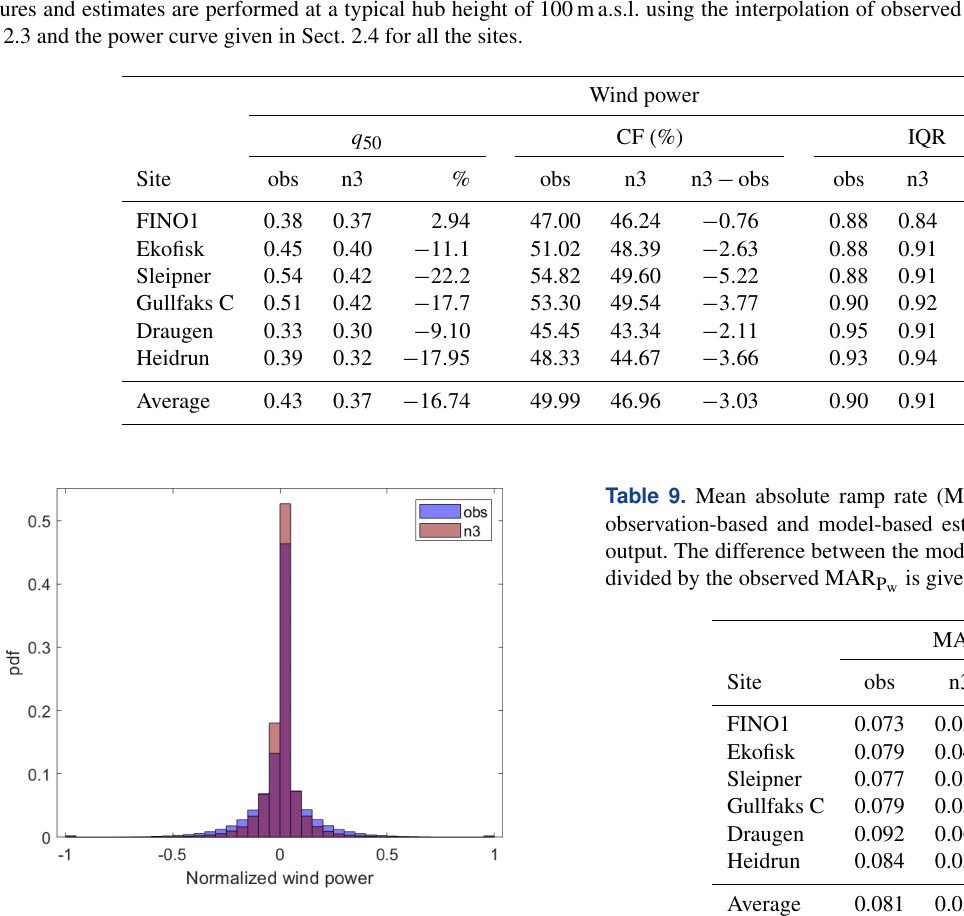
Figure 6. The probability density function (pdf) of the ramp rates for observation-based (obs) and model-based (n3) hourly normal- ized wind power.